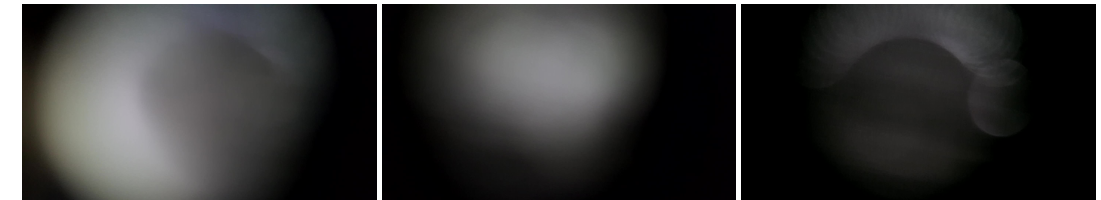
Figure 12. Due to rapid prototyping with a 3D printer and the manual assembly of the sensor hardware, the measurement chambers were not 100% identical, resulting in different background